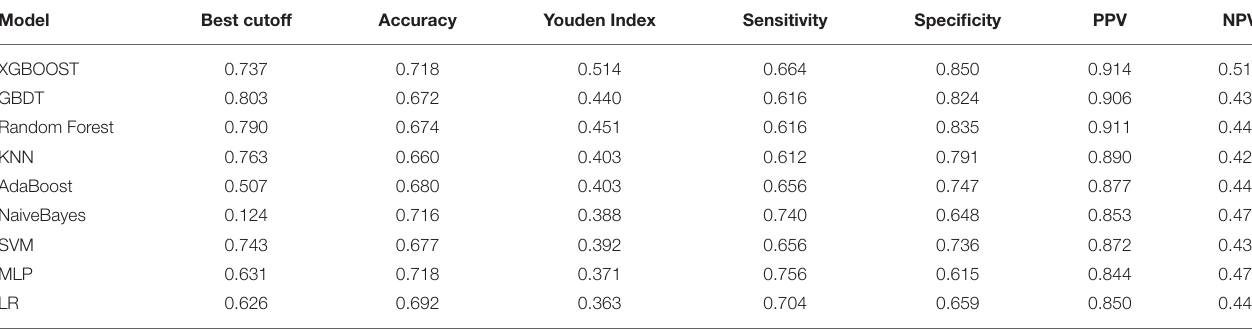
TABLE 2 | Analysis of sensitivity and specificity. Model